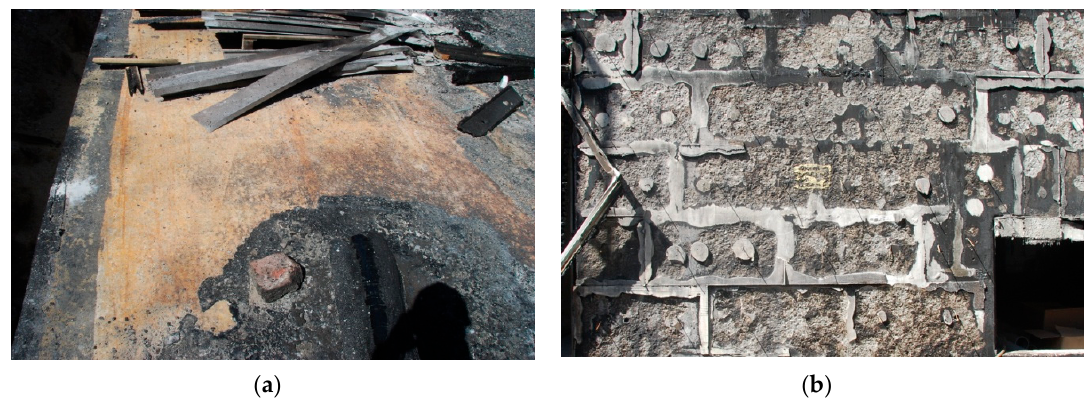
Figure 2. Concrete surfaces after fires: ( a ) top surface partially covered with watertight bituminous material, ( b ) vertical surface insulated with Styrofoam.